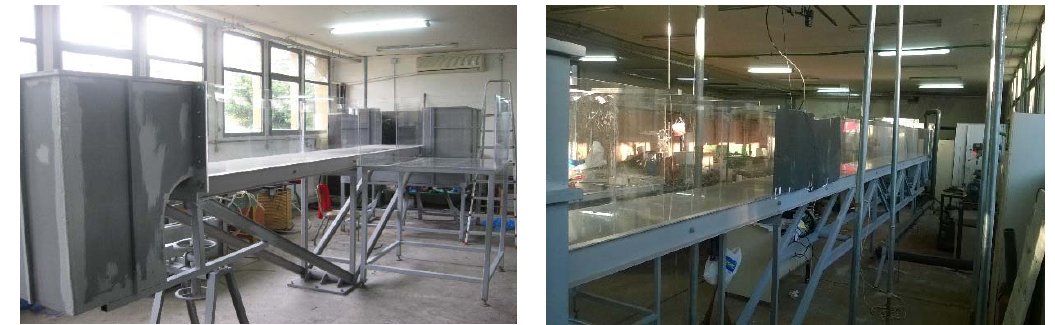
Figure 1. Experimental set ‐ up : front and back sidelong view of the